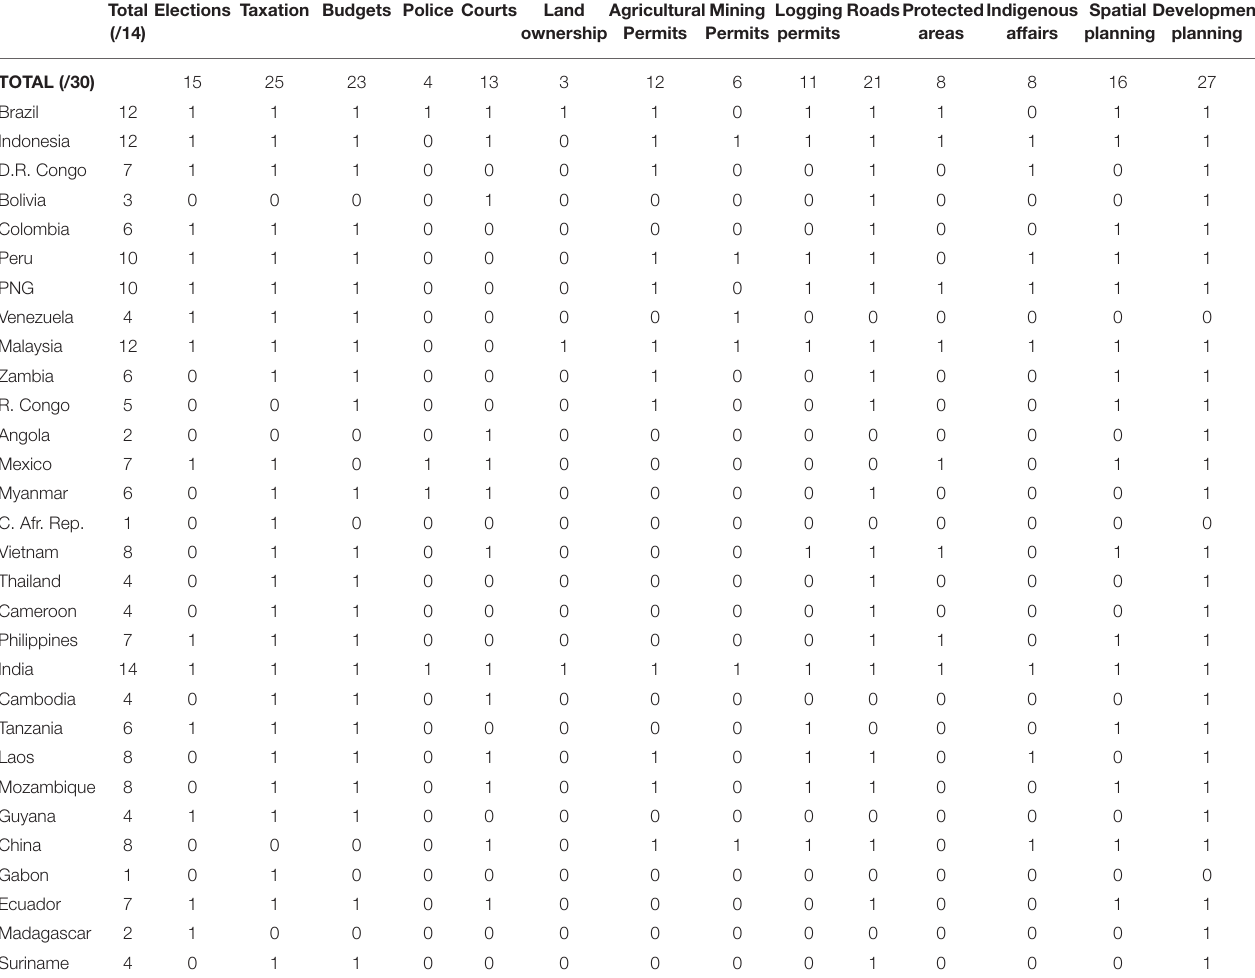
TABLE 2 | Authorities of second-tier governments, by country. Total Elections Taxation Budgets Police (/14)